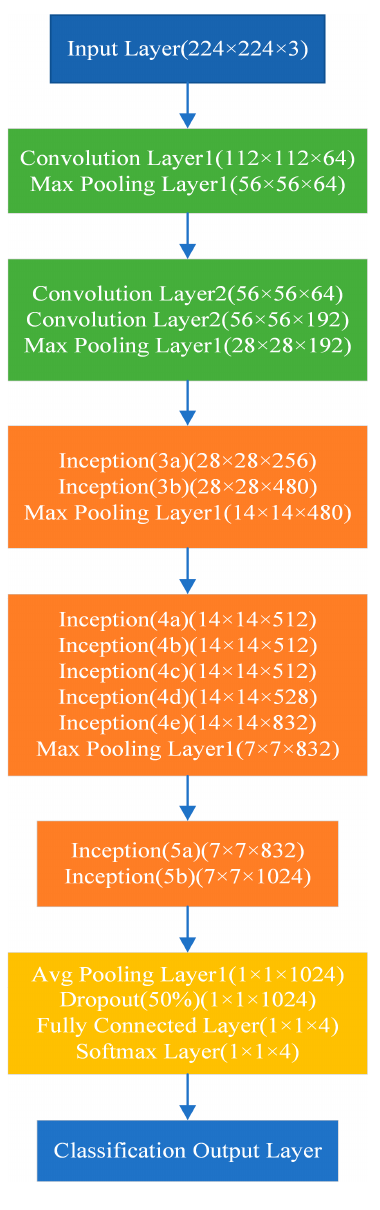
Figure 9. The structure of DNN model.